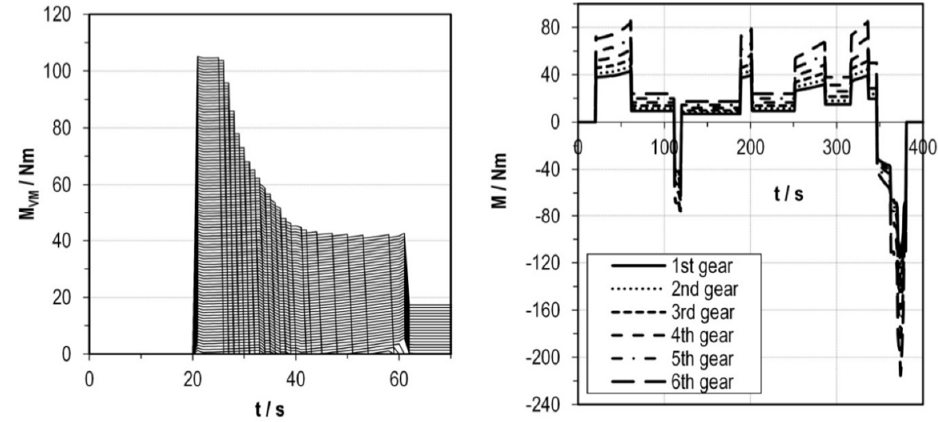
Figure 6. Left: EUDC-related optional torques at gearbox input for all gears (before testing against operational limits). Right: optional EM torques of the first gear (first 70 s of EUDC only). Calculations using C-segment PAH with SI engine.